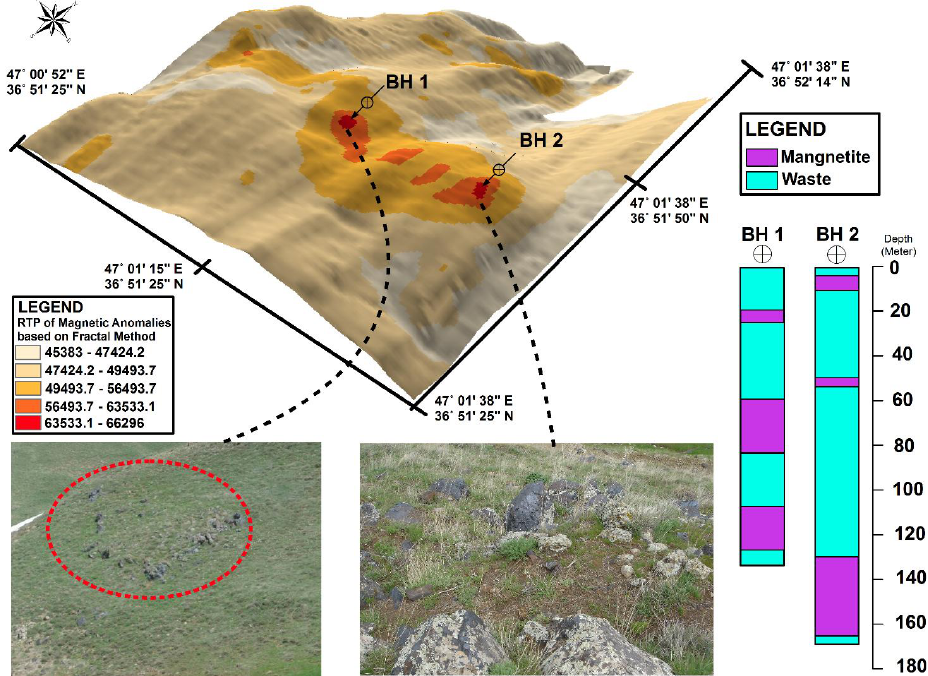
Figure 9. Three-dimensional RTP map of Qoja-Kandi based on the C – A method with pictures from magnetite zones in the surface of drilled boreholes 1 and 2, in addition to the mentioned boreholes’ log plots. Table 3. Log report of boreholes with RTP classification based on the fractal